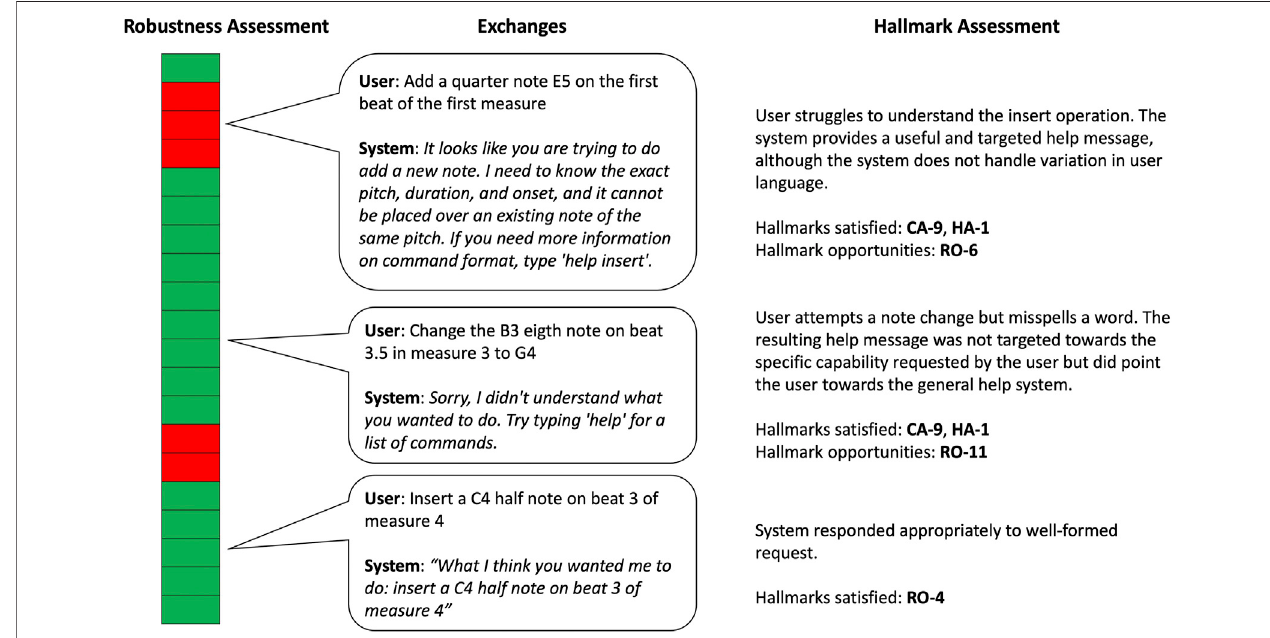
FIGURE 10 | An example of the coding of a composition by conversation human-computer interaction log for robustness. Green blocks represent successful interactionsbetweenthehumanpartnerandthesystem.Redblocksindicatethoseinteractionswherethemachinedidnotrespondappropriately.Hallmarkssatis fi edby the exchange as well as Hallmarks that aren ’ t satis fi ed but might be potential opportunities for improvement are indicated under the “ Hallmark Assessment ” column.